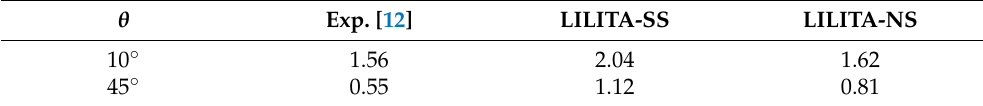
Table 2. Double differential multiplicities ratio among α particles and protons measured at most forward ( θ lab = 10 ◦ ) and most backward ( θ lab = 45 ◦ ) directions. The experimental data from the literature are compared with LILITA_N21 calculations using the SS and NS prescriptions. For more details, see the